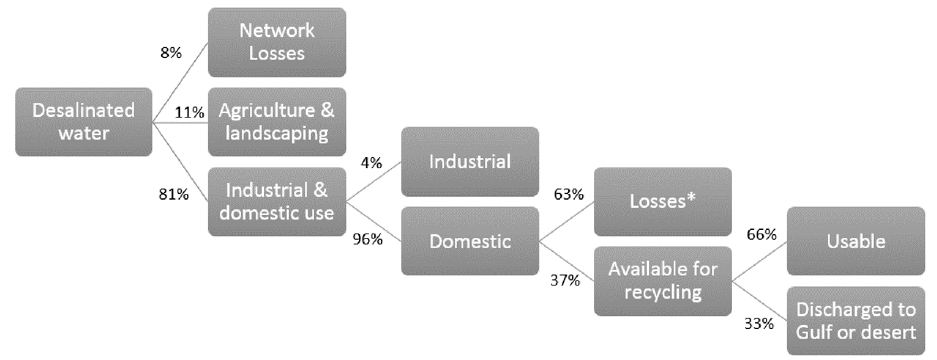
Figure 7. Desalinated water uses breakdown.